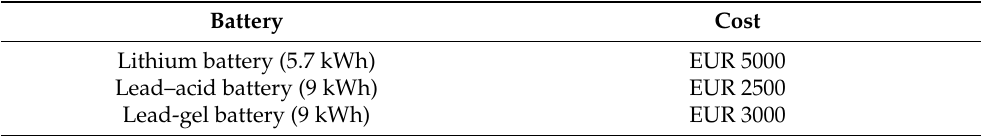
Table 5. The purchase costs of storage batteries.